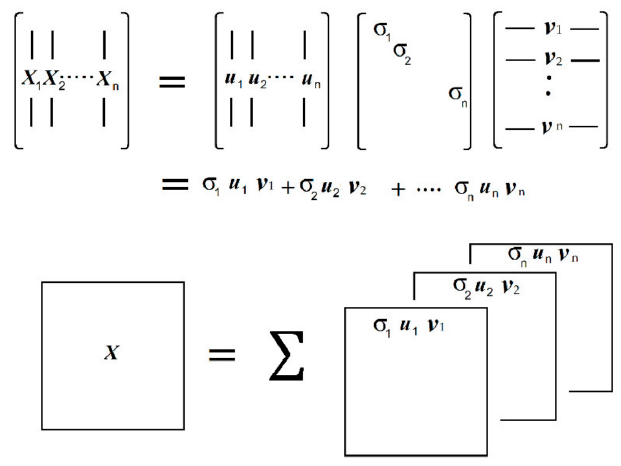
Figure 8. Singular value decomposition and reconstruction process of a 2-dimensional matrix.